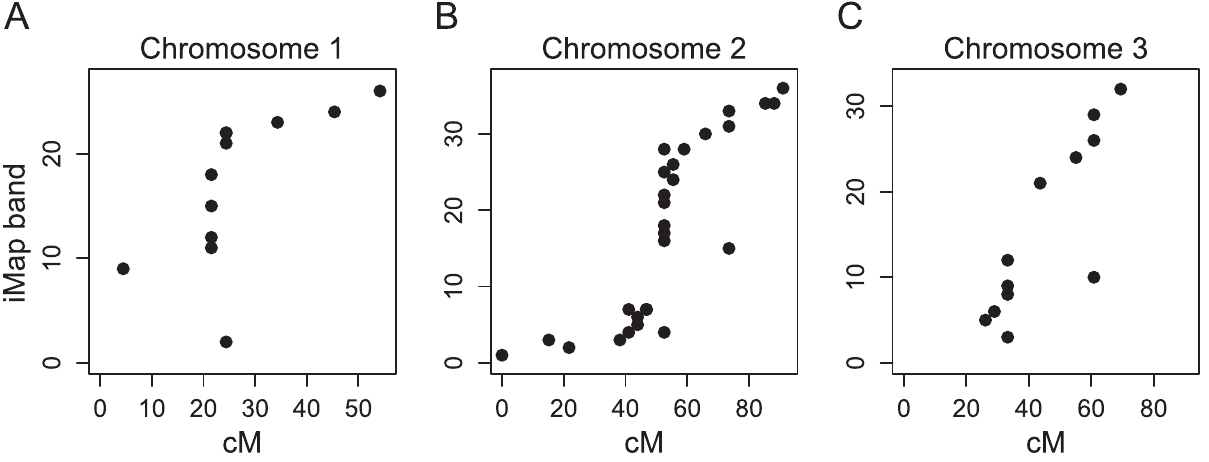
Figure 3. The correlation between the cM position of a scaffold on our genetic map and its position on the previously published integrated map [ 20 ] . The positions of scaffolds on chromosomes 1 (A), 2 (B), and 3 (C) are significantly correlated between the map presented here and the previously published map order (Spearman correlation, A: r =0.803, P =0.0017; B: r =0.899, P =0 , 0.0001; C: r =0.857, P =0.0004). Outliers are potentially caused by unidentified scaffold misassemblies. In cases where we found a scaffold to be misassembled, the correlation was performed by using the genetic map position of the contig closest to the one used in [20]. In one instance on Chromosome 2 and two instances on Chromosome 3, scaffolds mapped to a different chromosome in [20] than on our genetic map and these are not included in this